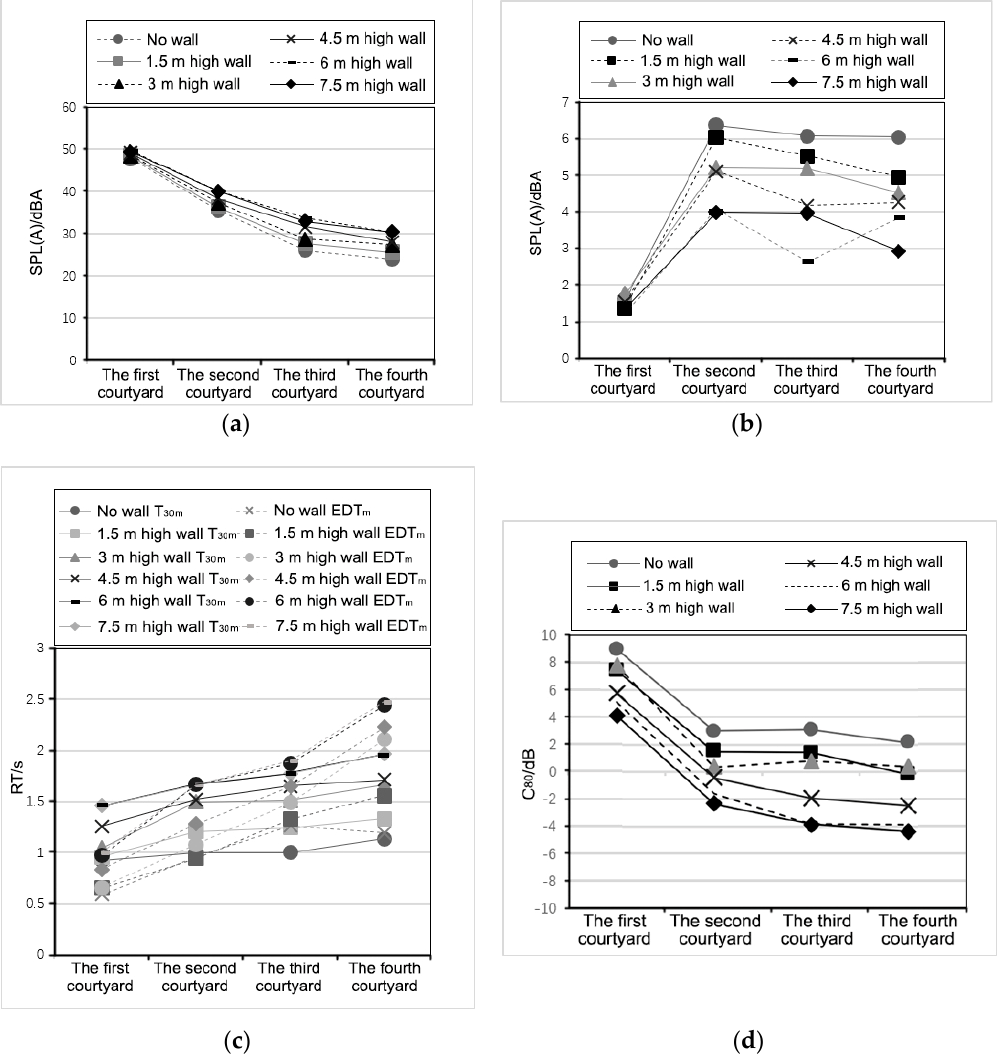
Figure 6. Diagrams of the effects of wall height on courtyard sound fields. ( a ) Variation in weighted SPL(A). ( b ) Variation in the standard deviation of SPL(A). ( c ) Variation in RT. ( d ) Variation in C 80 .